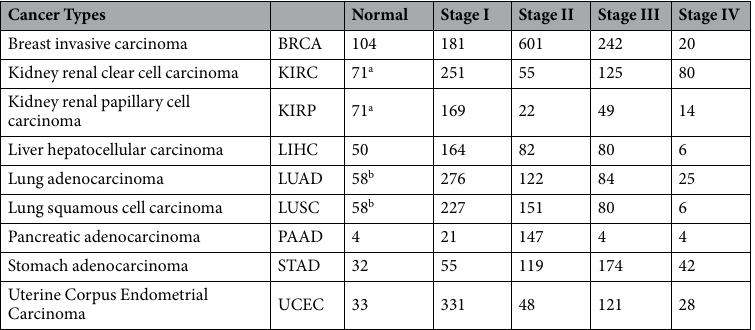
Table 5. Detailed statistics of samples from nine cancer types. a The same set of normal samples were used in two type of Kidney cancers; b The same set of normal samples were used in two type of Lung